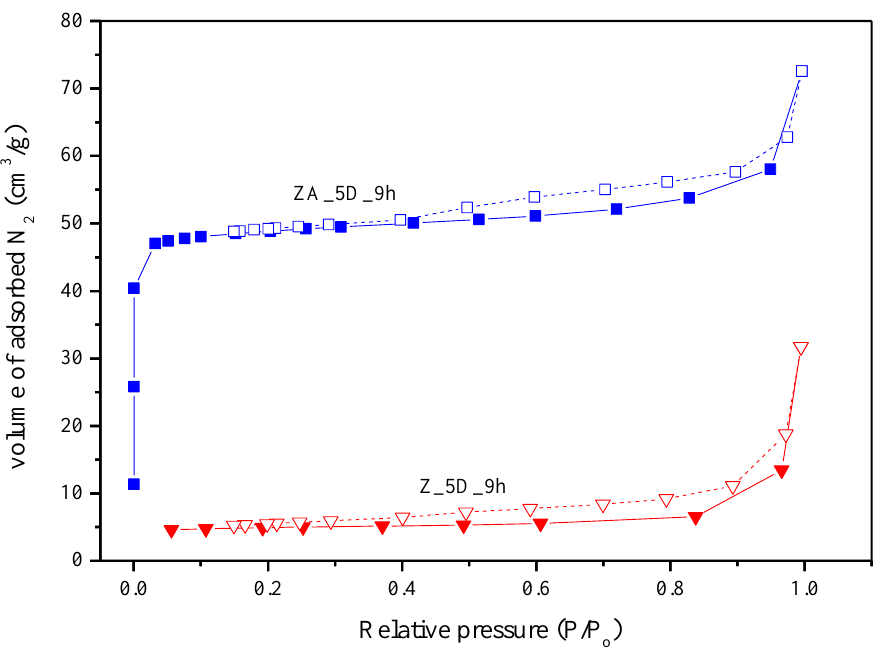
Figure 3. N 2 adsorption–desorption isotherms of zeolite without additives (Z_5D_9h) and with additives (ZA_5D_9h) obtained from an optimal aging and a crystallization time.